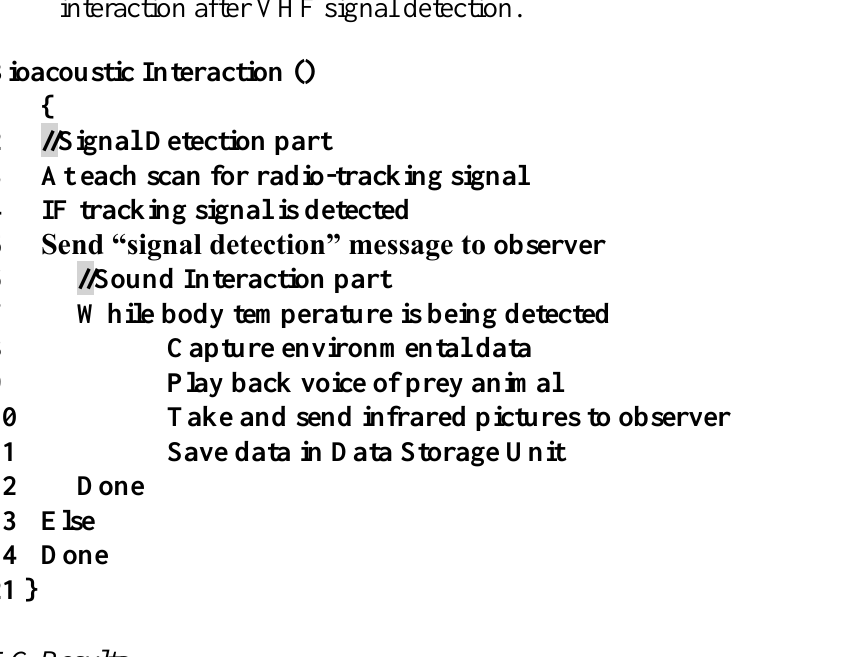
Figure 16. Pseudocode for the bioacoustic interaction function, producing the sound interaction after VHF signal